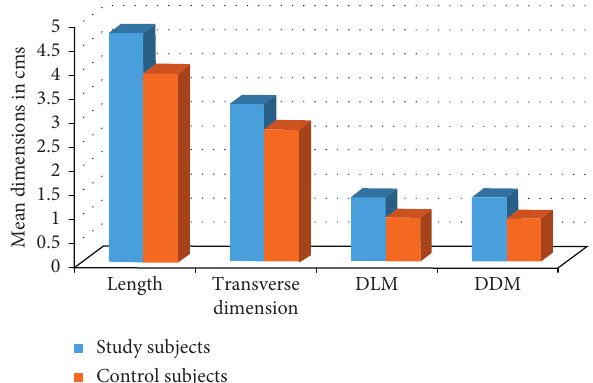
Figure 6: Graph showing comparison of ultrasonographic mea- surements of parotid glands in study subjects to control